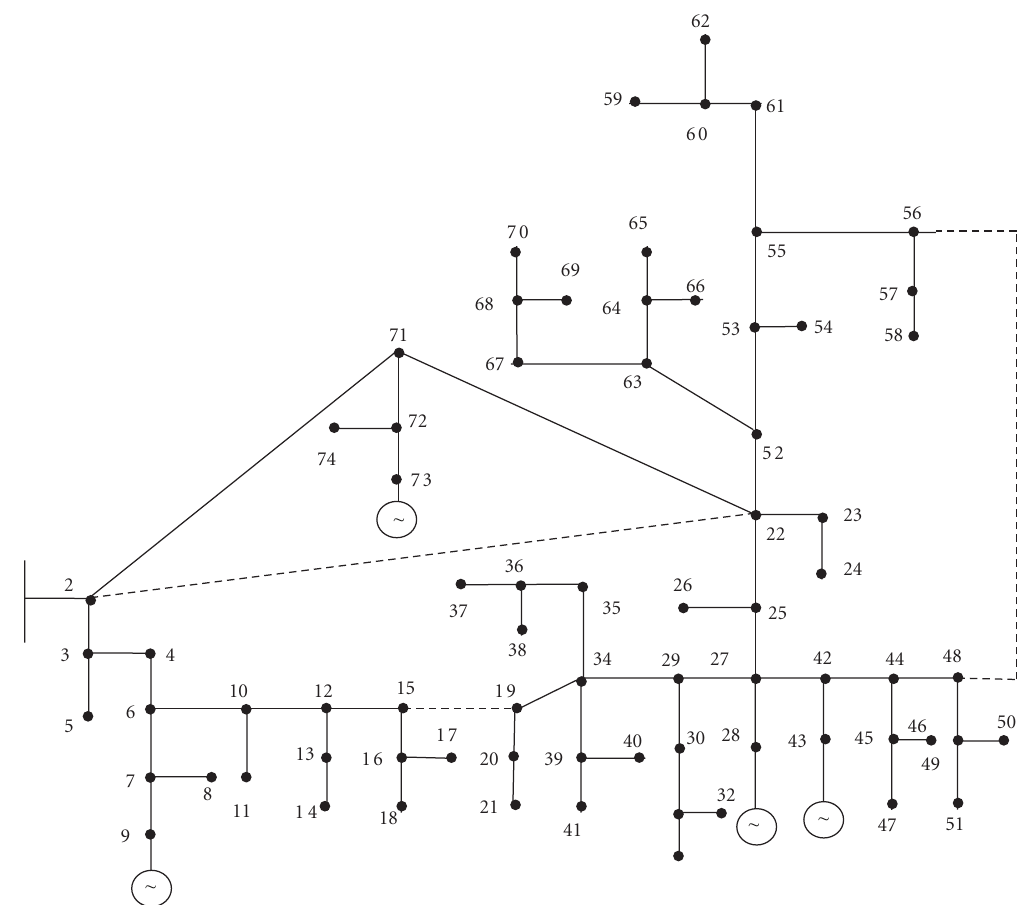
Figure 3: Optimal points of electric network tripping in the context of requirements of the normal and postemergency conditions.